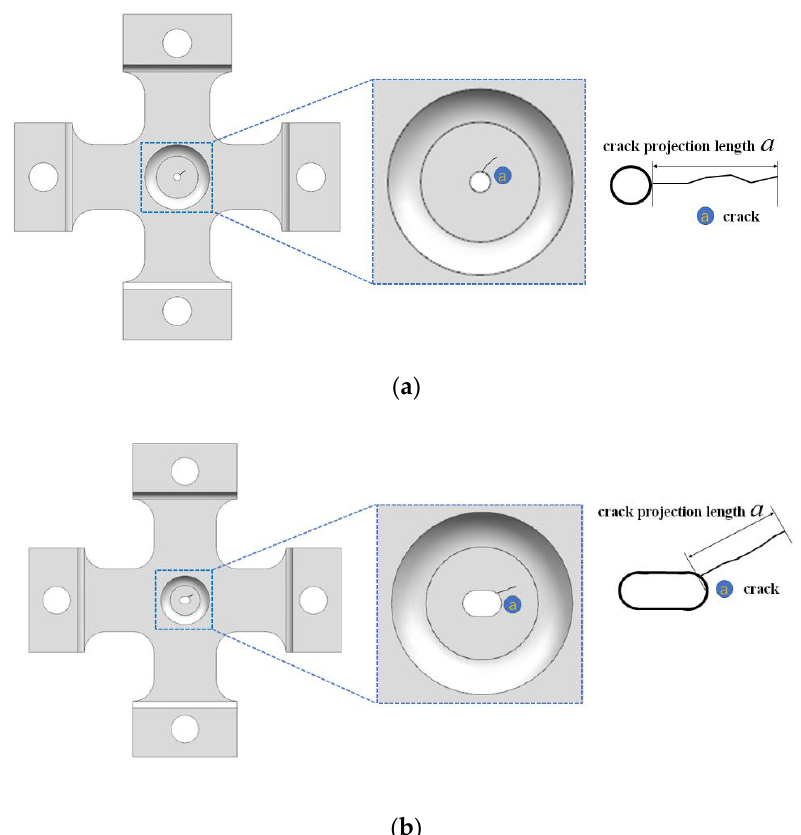
Figure 7. Crack projection length definition. ( a ) Crack projection length of circular notch specimen in central region. ( b ) Crack projection length of 0° waist circular hole notch specimen in central region.